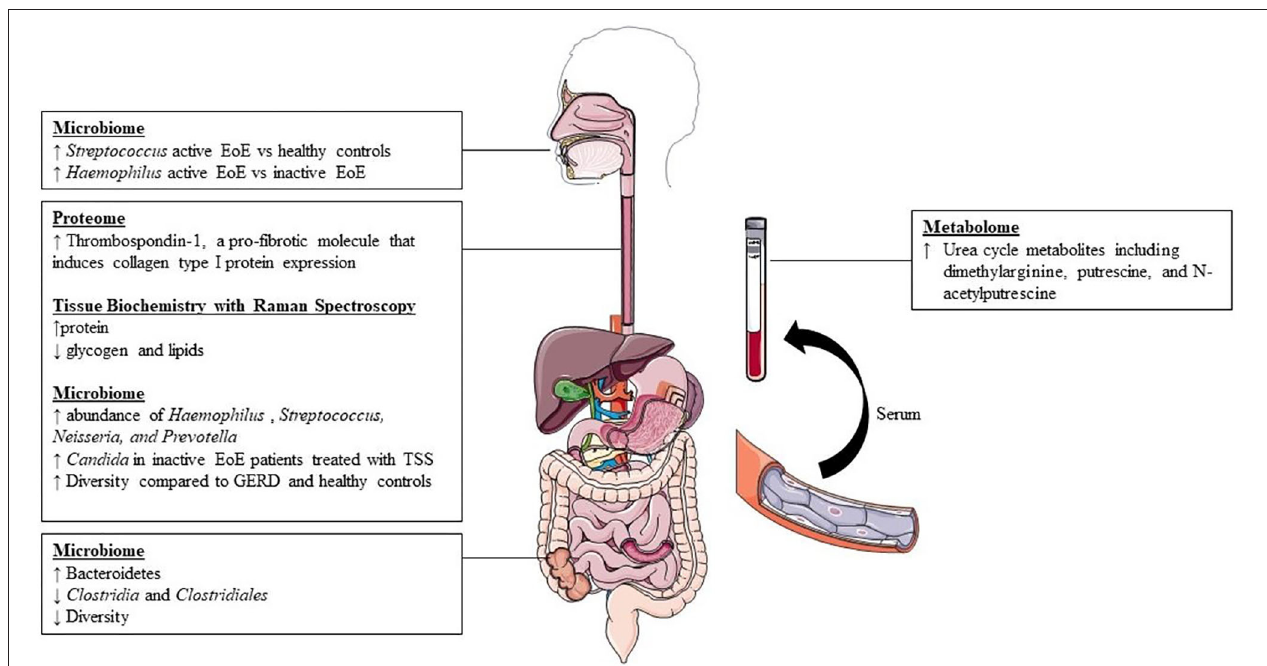
FIGURE 2 | Summary of available findings from literature.